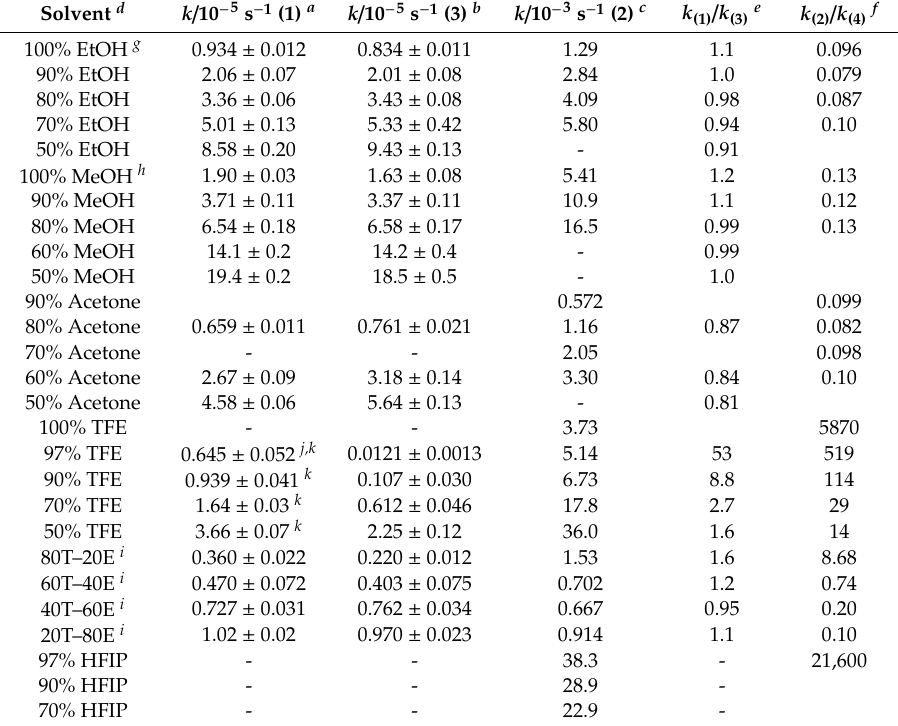
Table 1. Rate constants ( k ) of solvolysis of o -nitrobenzyl bromide ( 1 ) a and p -nitrobenzyl bromide ( 3 ) b at 45.0 ◦ C, and o -nitrobenzoyl chloride ( 2 ) c at 25.0 ◦ C, in aqueous binary mixtures and comparisons, / k / k and k and k ( 4 ) ratios, with corresponding values for the solvolyses of ( 1) ( 3) ( 2) p -nitrobenzoyl chloride ( 4 )).